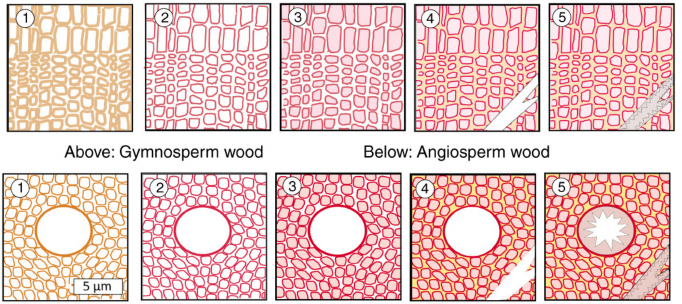
Figure 32. Typical mineralization sequences for angiosperms and gymnosperms, transverse views. Gymnosperms lack conductive vessels, with fluid transport occurring via tracheid cells. Angiosperms have conductive vessels surrounded by fiber cells. These anatomical characteristics affect mineral- ization. ( 1 ) Unfossilized wood. ( 2 ) The first step in mineralization is the deposition of silica in cell walls. ( 3 ) This is followed by precipitation of silica in cell lumen in fiber cells (angiosperms) and tracheids (gymnosperms). ( 4 ) Minerals fill intercellular spaces, producing brittleness that makes the material subject to brittle fracture if deformation occurs. ( 5 ) Large open spaces are the last areas to be mineralized. These spaces include vessels in angiosperm wood, and fractures or rotted areas in wood of all species. Because of the time lag between each mineralization episode, changes in geochemical conditions may cause different silica polymorphs to be deposited at each stage of mineralization. Subsequent diagenesis may alter the original